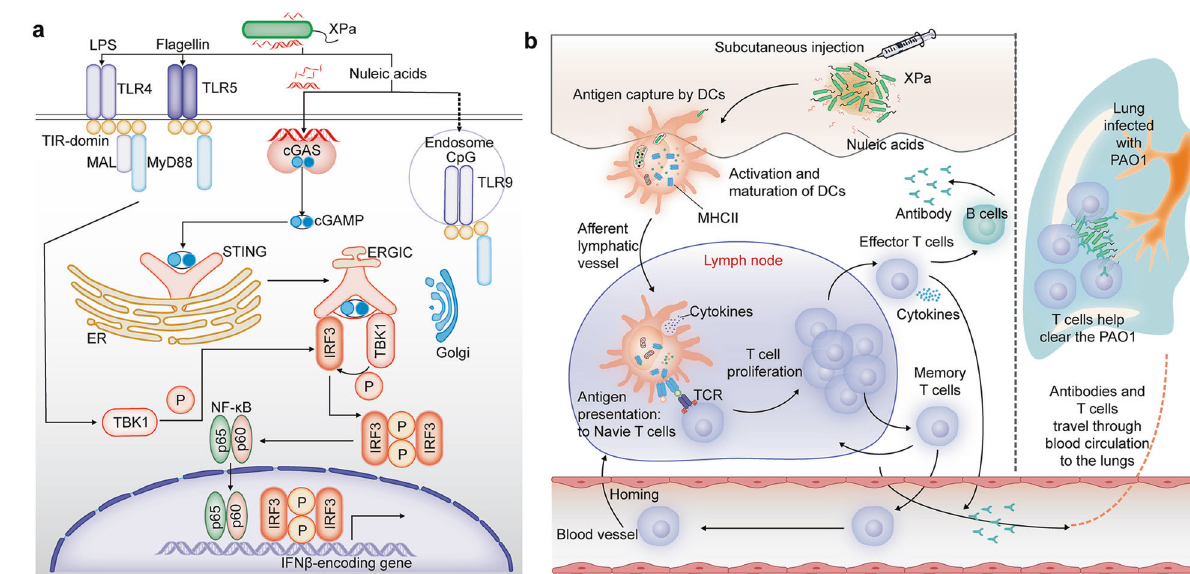
Fig. 4 Activated pathways in DCs stimulated by XPa and the immune response during immunization and infection. a The activated pathways in DCs induced by XPa. TLR4 recognizes LPS, TLR5 recognizes the fl agellin protein, the cGAS-STING pathway is stimulated by nucleic acids, and TLR9 recognizes CpG (which was not detected in XPa). MyD88 can activate IRF3 through the TBK1 protein in TLR4 signaling, thus increasing downstream gene expression (MyD88 – TBK1-independent genes). b The immune response during immunization and infection. Upon encountering XPa, DCs are rapidly activated and become mature. Mature DCs migrate to the lymph nodes where DCs present antigens to T cells. Following antigen encounter, T cells are activated, proliferate, and differentiate into effector and memory T cells (TCMs and